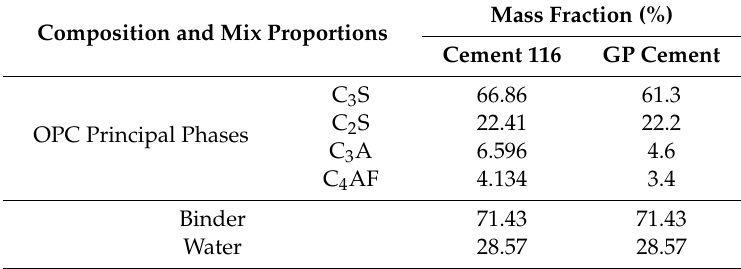
Table 3. Comparison of composition for VCCTL Cement 116 and Australian type GP